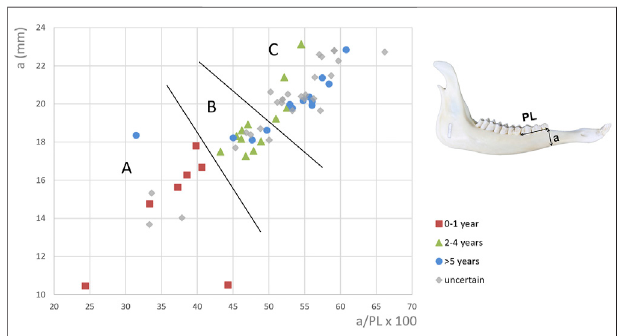
FIGURE 6 | Mandible measurements showing sexual dimorphism. The plotsclusterintothreegroups: (A) fawnsandyearlings; (B) femalesandyoung males; (C)